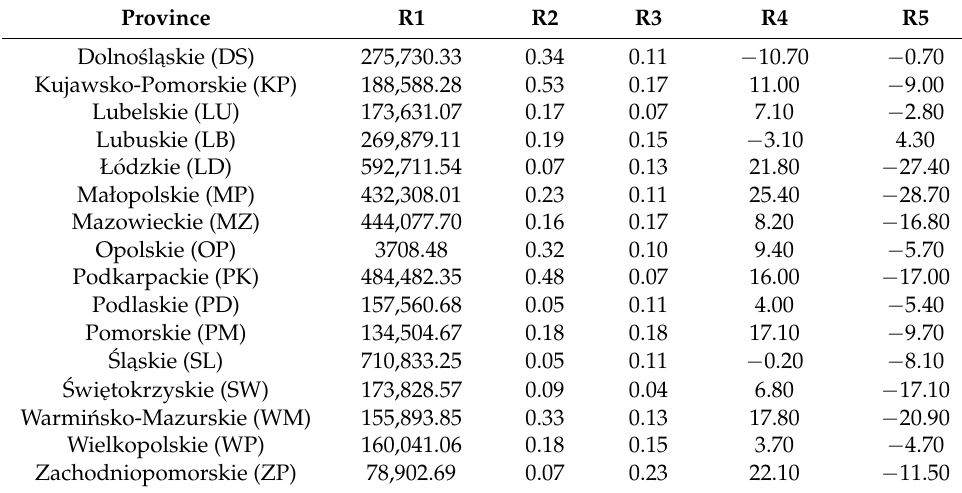
Table 3. Road transport development evaluation—main characteristics (ratios) obtained for provinces. Source: the